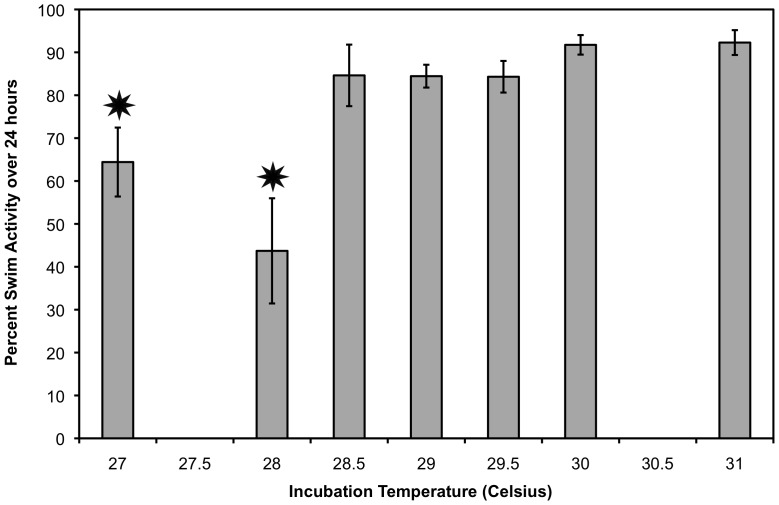
The effect of incubation temperature on overall swimming activity ± S.E.M. in 2011.Hatchlings from 27°C and 28°C (stars) were significantly less active than those from all other incubation temperatures (F2,6 = 8.022, p<0.0001). Incubation temperature maintained a significant effect on hatchlings from 27°C when the two hatchlings incubated at 28°C were removed from the analysis. [Sample size: 27°C n = 4; 28°C n = 2; 28.5°C n = 7; 29°C n = 14; 29.5 n = 10; 30°C n = 6; 31 n = 4].